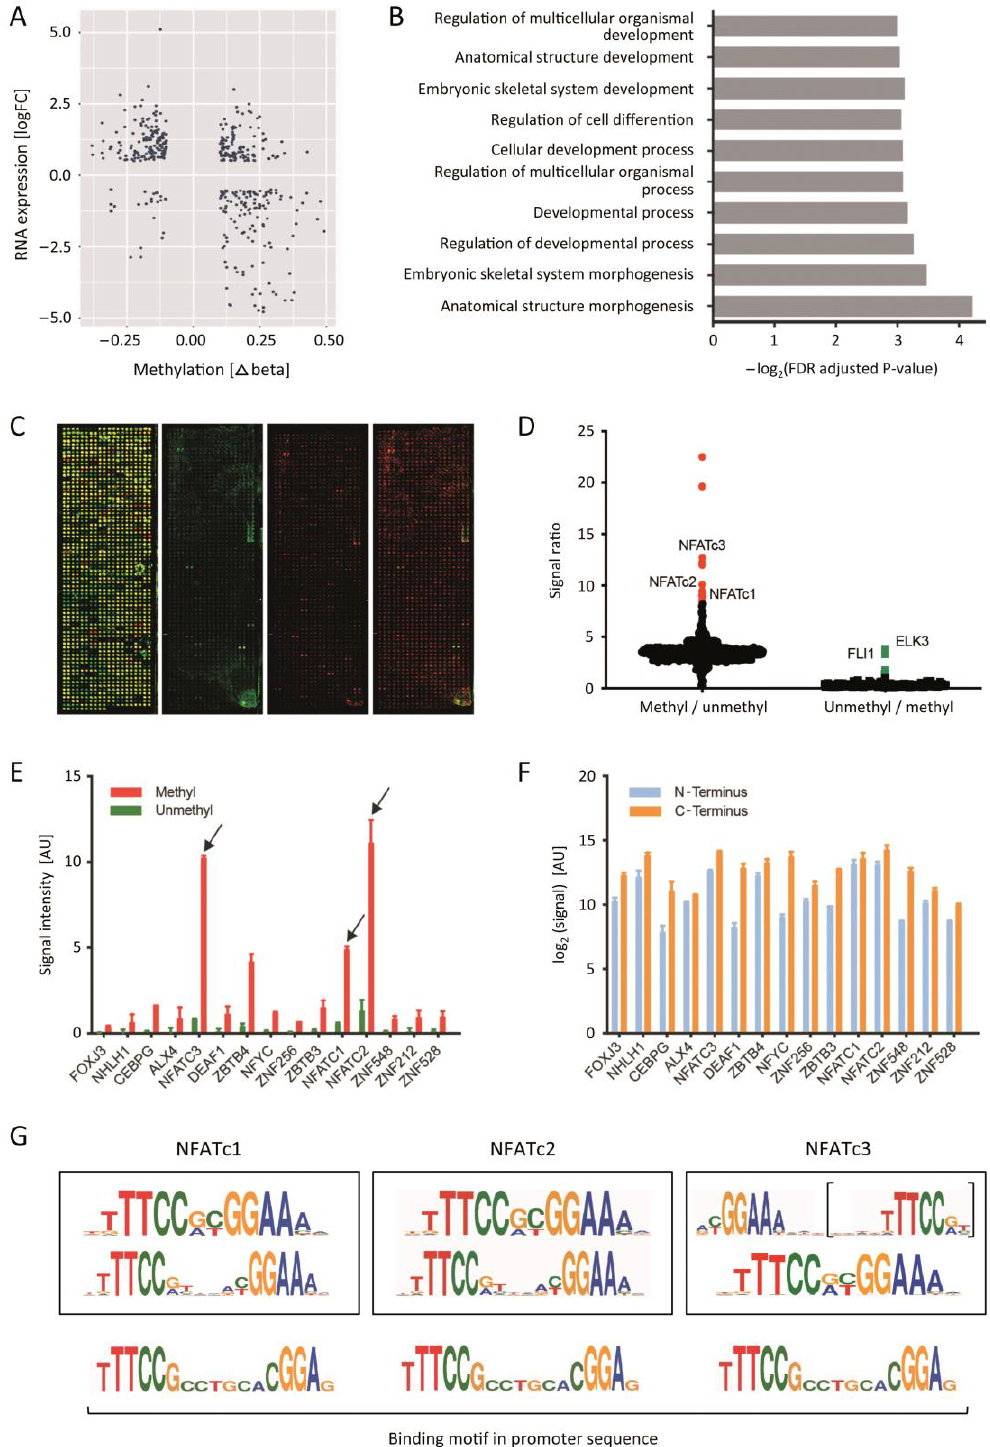
Figure 1. Identification of transcription factors that preferentially bind to methylated sequences. ( A ) Integration of expression and methylation profiling data. Along the x-axis, DNA methylation variations between PDAC and healthy tissues are shown as the mean delta beta value in the promoter regions ( − 1500/+500 bp); the log-fold change of transcript levels is presented along the y-axis. Each dot represents one gene. ( B ) Gene ontology term enrichment analysis of up-regulated and hypermethylated genes. The top 10 overrepresented processes are shown. ( C ) Typical images of the protein microarray with 658 TF DNA binding domains and seven full-length TFs. Left: Terminal tags present in each protein were stained with fluorescently labelled antibodies. Right: Results of incubations with an unmethylated (green) and methylated (red) 55 bp DNA fragment resembling the TWIST1 promoter; beside the individual images, also a merger is shown at the far right. ( D ) Signal ratios were calculated of methylated over unmethylated and vice versa signal intensities. Red or green